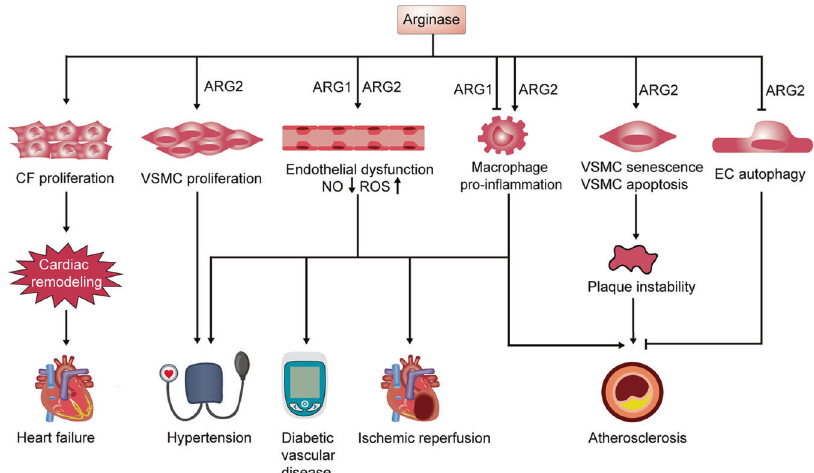
Fig. 3 Arginase promotes various CVDs through regulating cellular functions and endothelial dysfunction. Arginase can promote CF proliferation and contribute to cardiac remodeling, which plays a crucial role in heart failure. ARG2 expression can induce the VSMCs proliferation, a hallmark characteristic of hypoxia-induced PAH. Furthermore, upregulated arginase induces endothelial dysfunction via NO reduction and ROS production, which promotes the development of a variety of CVDs such as hypertension, diabetic vascular disease, ischemic reperfusion and atherosclerosis. Moreover, ARG2 leads to atherosclerotic plaque instability through promoting VSMC senescence and apoptosis and dampening endothelial autophagy in atherosclerosis. ARG2 expression triggers macrophage pro-in fl ammatory responses, resulting in the development of atherosclerosis. CVDs cardiovascular diseases, CF cardiac fi broblast, VSMC vascular smooth muscle cell, EC endothelial cell, PAH pulmonary arterial hypertension, NO nitric oxide, ROS reactive oxygen